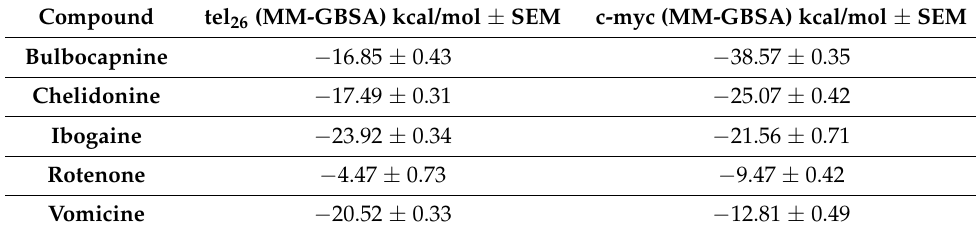
Figure 5. Representative binding conformation of selected ligands to a DNA duplex extracted from MD trajectories. ( A ) duplex/Bulbocapnine; ( B ) duplex/Chelidonine; ( C ) duplex/Ibogaine; ( D ) duplex/Rotenone; ( E ) duplex/Vomicine. The DNA duplex is shown as lines and cartoon. Small molecules are shown as yellow sticks. Metal ions and water molecules have been omitted for the sake of clarity. Duplex/ligand polar interactions are highlighted by black dashed lines. The same orientation of each duplex/ligand complex is shown, which was obtained by structural alignment on the phosphate backbone. Table 4. Theoretical affinity of selected ligands to tel 26 and c-myc G4 structures calculated along MD